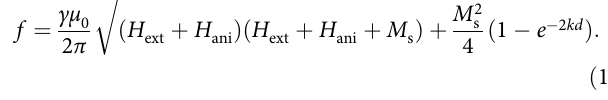
three different magnonic crystals, a 30 w 2.5, a 30 w 5, and a 50 w 5, with orange and green lines representing data for pure YIG and CoFeB/YIG lattices, respectively. Whereas both types of crystals show robust bandgaps, their widths are slightly larger for stripe arrays with air grooves. Moreover, the spin-wave signal decays faster in crystals made of pure YIG, which is particularly apparent for w = 5 μ m. Filling of the air grooves with CoFeB thus enhances the ef fi ciency of spin-wave transmission in nanometer-thick YIG- based magnonic crystals.